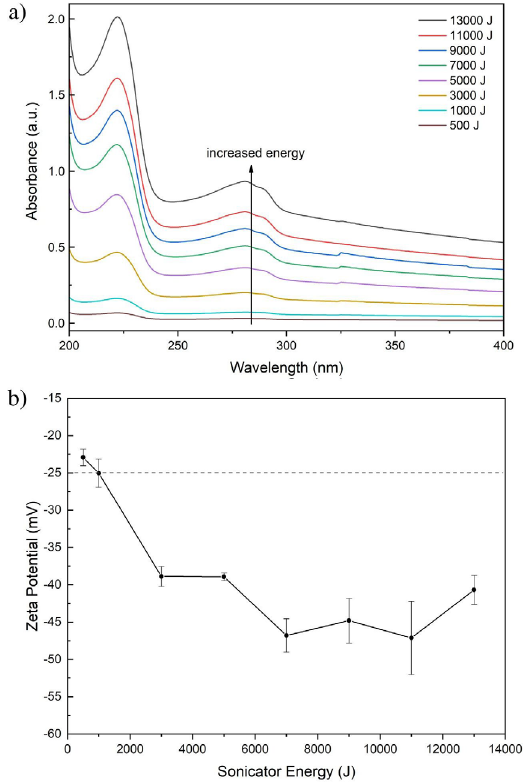
Figure 4. Absorption spectra (a) and Zeta potential (b) of MWCNT water dispersions produced with different sonication energies with 0.5 wt.% of Triton X-100